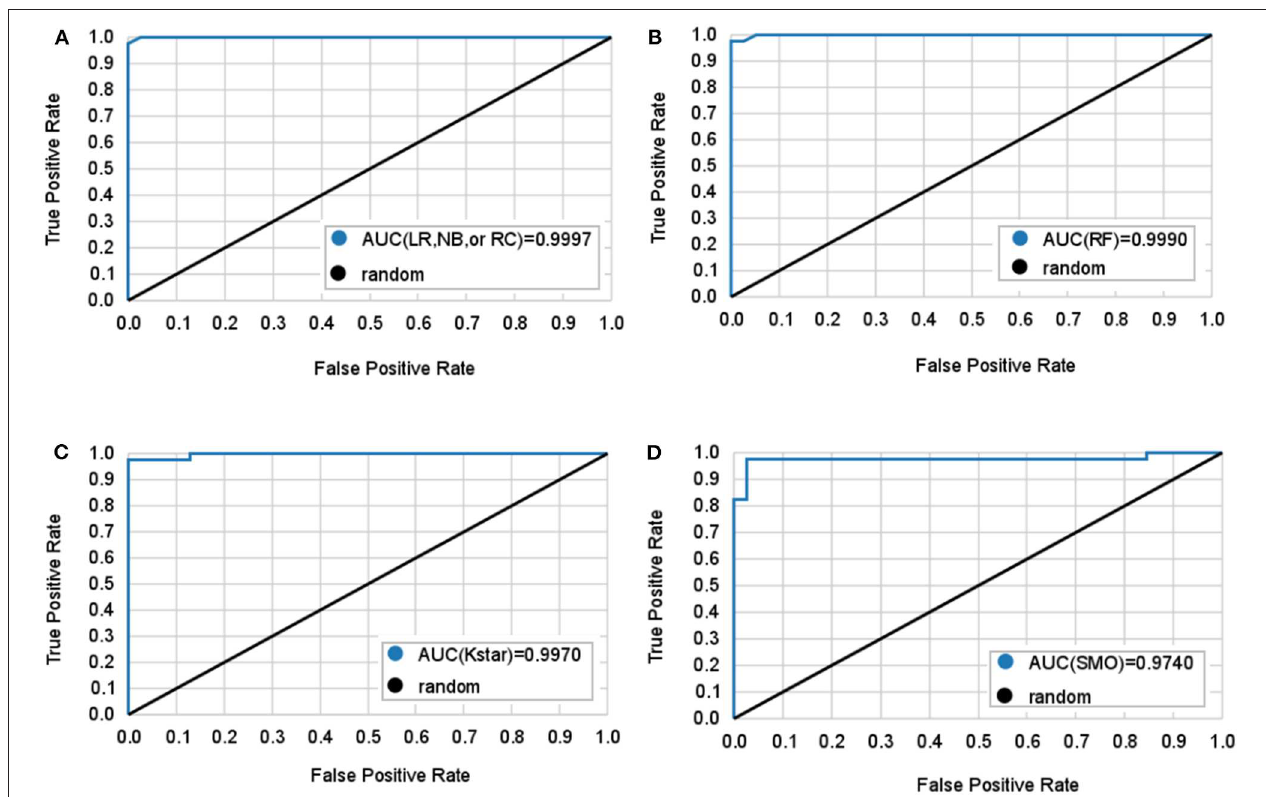
FIGURE 2 | Mean ROC curves obtained by six machine learning models for predicting lung adenocarcinoma. The black diagonal line in the diagram is the random line which is the worst possible performance a model can achieve. (A) Logistic regression (LR), naive bayes (NB), and random committee (RC) classifiers all have the same AUC. (B) Random forest (RF) classifier. (C) Kstar classifier. (D) Sequential minimal optimization (SMO)